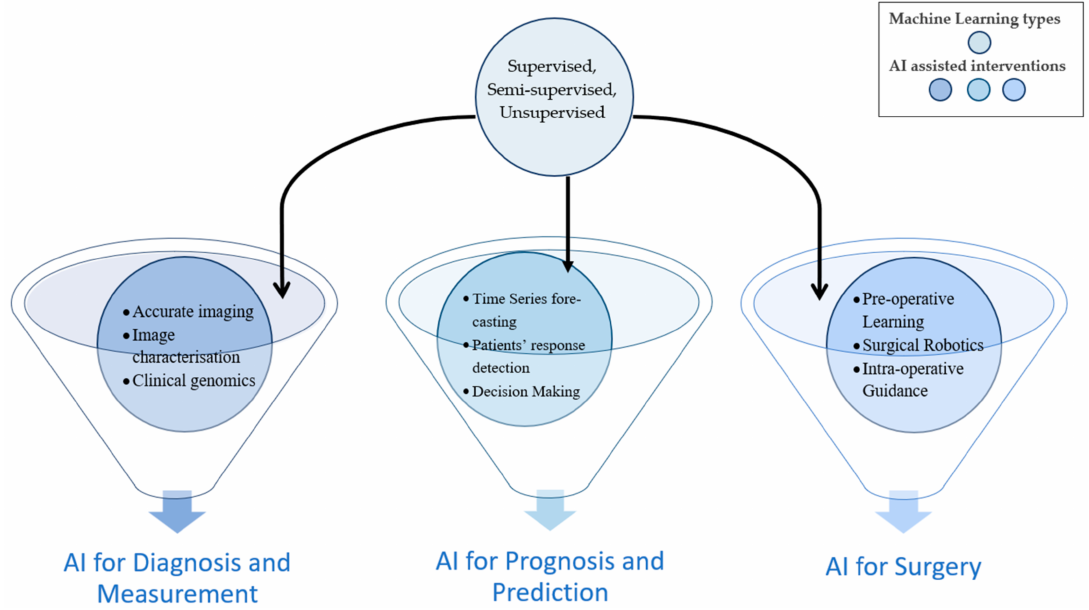
Figure 3. Popular AI techniques for diagnosis, measurement or prediction, prognosis and surgery. Robot-assisted surgery may be used to research and further develop the use of AI in surgical practice by providing complete telemetry and a sophisticated viewing